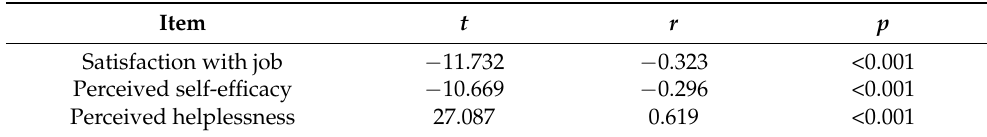
Table 2. Pearson (cid:48) s product-moment correlations of dimensions of burnout with exhaustion fac- tor score. Item t r p Satisfaction with job − 11.732 − 0.323 <0.001 Perceived self-efficacy − 10.669 − 0.296 <0.001 Perceived helplessness 27.087 0.619